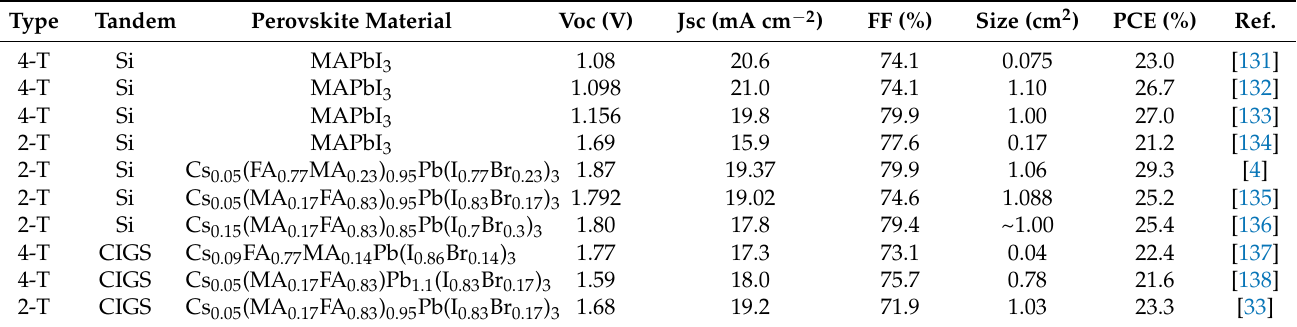
Figure 7. Schematic diagram of ( a ) 2-T and ( b ) 4-T tandem perovskite. Based on the values shown in Table 2, Voc, Jsc, and FF have similar in values with the 4-T Si/MAPbI 3 configuration [131–133] and the values of Voc, Jsc, and FF in these works are about 1.1 V, 21 mA cm − 2 , and 75–80%, respectively. Table 2. Some reports of perovskite tandem PVs. Voc, Jsc, and FF are open-circuit voltage, short-circuit current density, and fill factor,